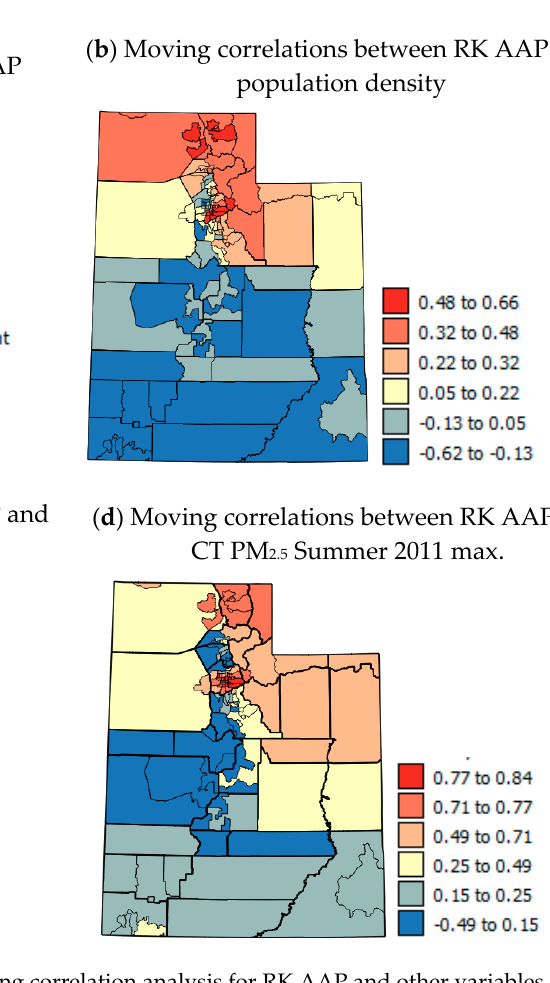
Figure 7. Local Moran’s I (LMI) and moving correlation analysis for RK AAP and other variables. Table 4. Correlations Between RK AAP and CT PM 2.5 data for metro and non-metro small areas. Pearson correlations with RK AAP Variable